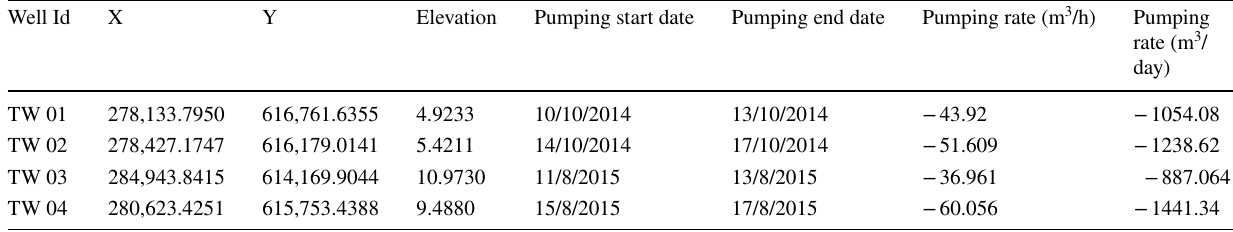
Table 3 Pumping rate for 3 days for test wells at the study area Well